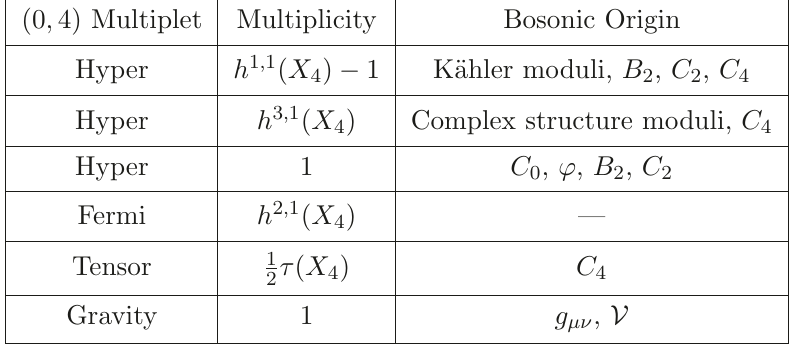
Table 1 . Spectrum of IIB on a Calabi-Yau fourfold X 4 in terms of the 2d (0 , 4) multiplet structure. The n f − anti-chiral real fermions from the gravitini contribute the equivalent of a total of n Fermi (0 , 4) Fermi multiplets, with n Fermi = h 2 , 1 ( X 4 )